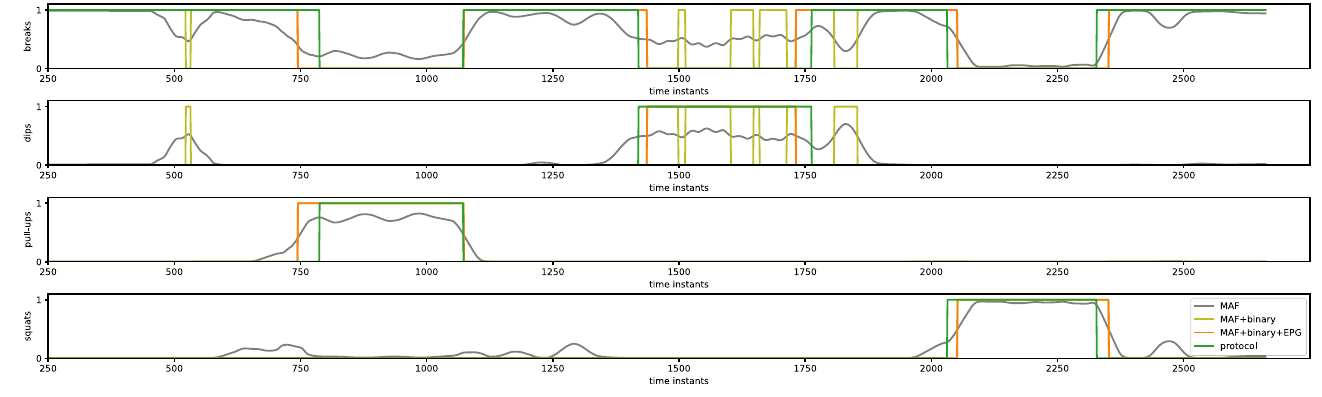
Figure 7. CNN output signal transformed by PPB filters.